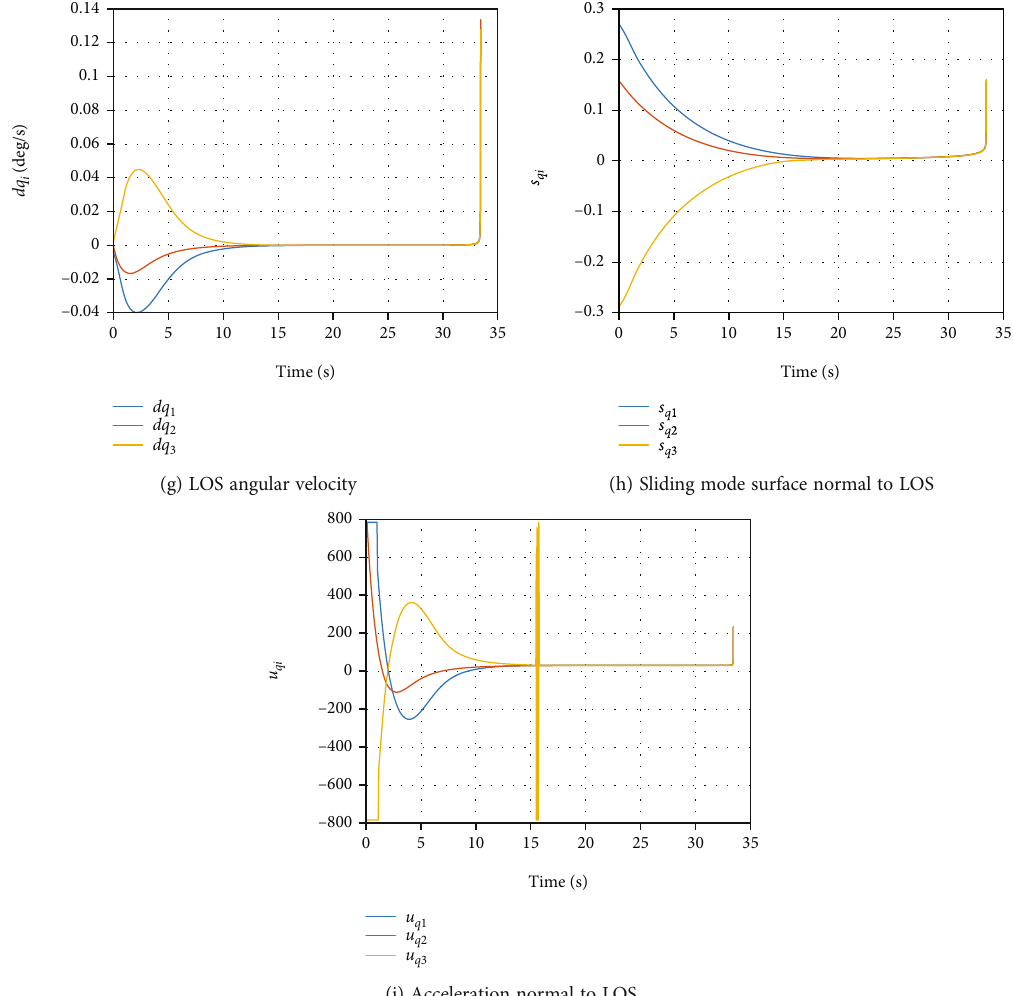
Figure 5: Response curves for Case